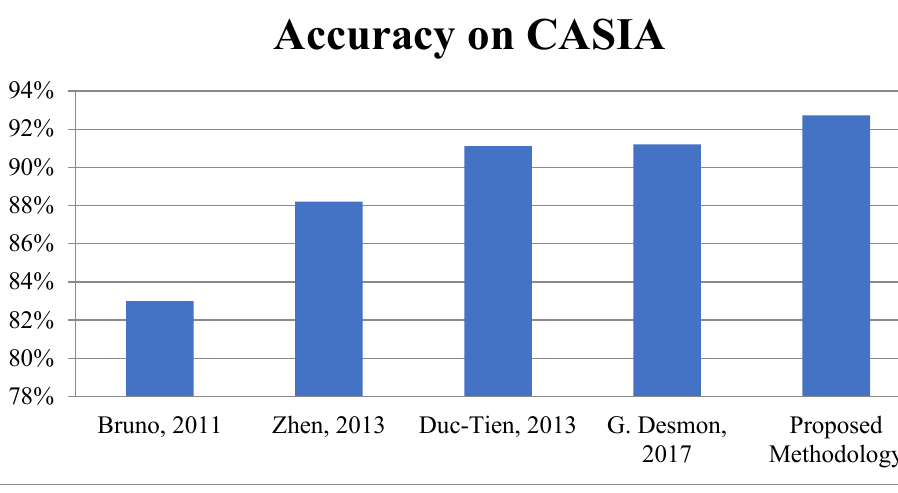
Figure 12. Accuracy Comparison for Face Spoofing on CASIA. Second Module: In the second module, the proposed work is evaluated on benchmark datasets, i.e., Adience and IOG for Age Classification. According to Table 6, it is very clear the proposed algorithm achieved 83.26 ± 4.3% and 76.3% accuracy for Age and theAdience and IOG database, respectively. The graphical representations of face spoofing results are shown in Figures 13 and 14.